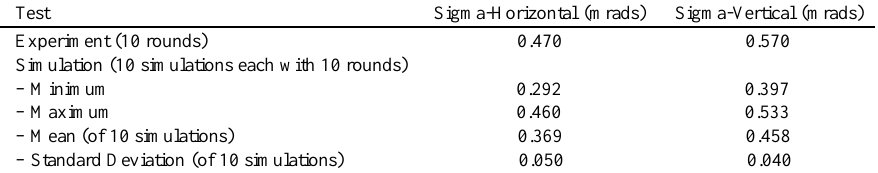
Table 5 Total dispersion